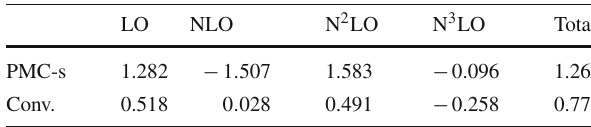
Table 1 Contribution from each order for the N 3 LO decay width (cid:3) 3 (in unit: keV) under the PMC-s and conventional ( μ r = 3 . 5 GeV) scale-setting